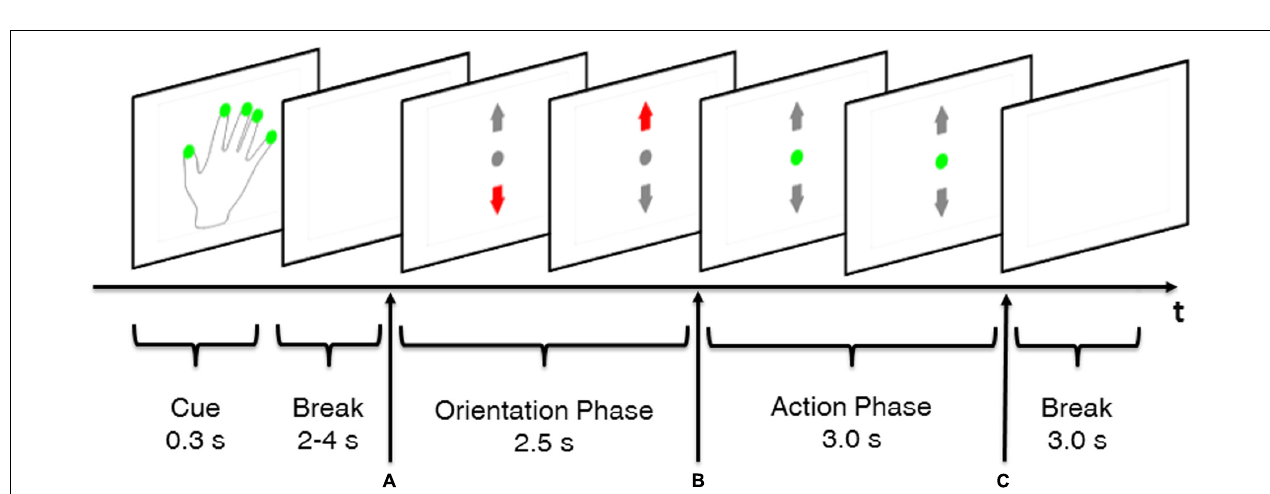
FIGURE 1 | Schematic drawing of the experimental setup and the experimental conditions. (A) The subject performs an isometric, isotonic grip around a cylinder. The motor task (MT) reflects a combined activation of motor and sensory cortices as efferent motor commands are generated and sensory feedback is processed simultaneously. (B) Subject is not involved in a MT but electrical stimulation of the fingertips is applied. The electrical stimulation simulates a sensory perception that resembles the superficial sensory input during the isometric grip in absence of the generation of efferent motor commands.